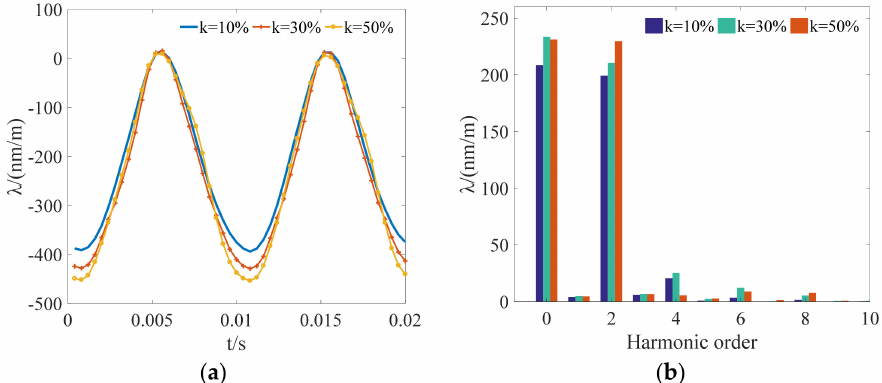
Figure 5. Measured results when the fifth harmonic is superposed to the fundamental component ( B m = 1.4 T, k 5 = 10%, 30%, 50%): ( a ) Waveforms of magnetostriction; ( b ) frequency spectrum of magnetostriction.